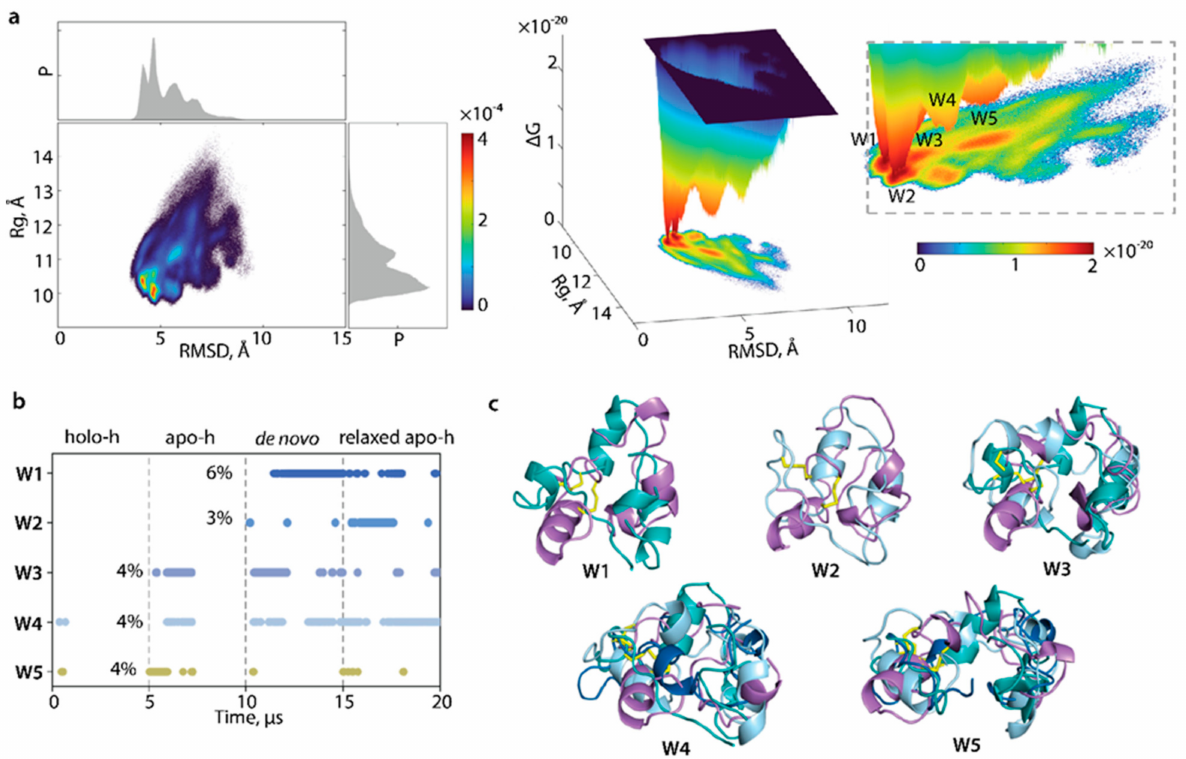
Figure 9. Free energy landscape ( FEL ) of cleaved L-loop as a function of reaction coordinates, Rg versus RMSD. ( a ) Two-dimensional- (left) and three-dimensional (middle) representations of the L-loop conformational ensembles’ relative Gibbs free energy, zoomed in on the principal wells (right). Probability density (P) of each reaction coordinate is shown on the 2D map top and right. ( b , c ) Content of each well (W1–W5) illustrated as the superimposed representative conformations. All conformations were generated by cMD simulations of different forms of L-loop and fitted on the average conformation calculated on the merged data. The red colour on 2D and 3D diagrams represents the highest occurrence, yellow and green low, and blue represents the lowest occurrence. The free energy surface was plotted using MATLAB. L-loop is shown as a cartoon distinguished by colour: the holo-h is in light blue, the apo-h is in dark blue, relaxed apo-h is in lilac, and de novo model is in teal. Content of wells for the merged data is shown over the concatenated time